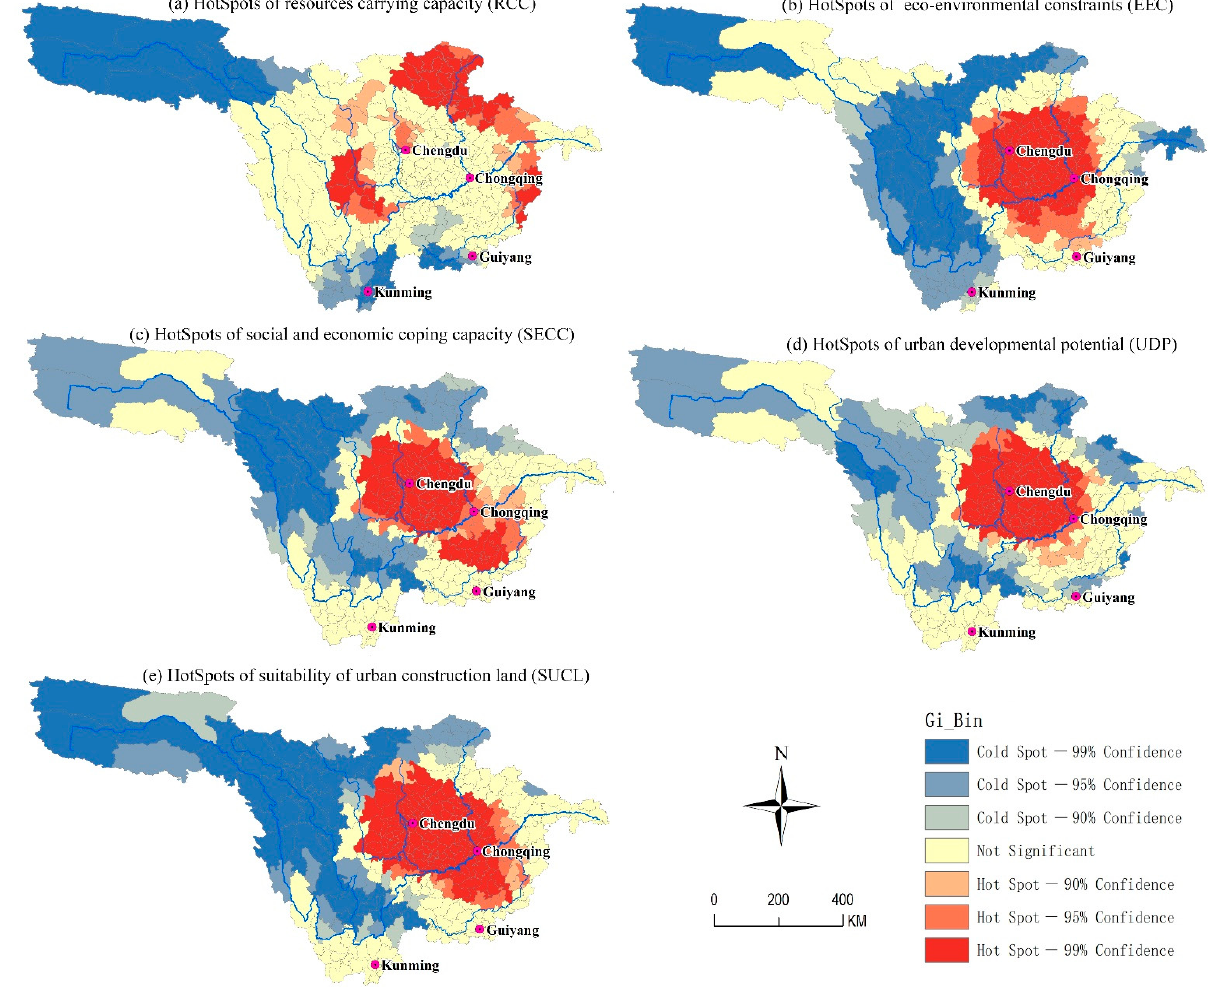
Figure 5. Spatial distribution of hot spots and cold spots of suitability of urban construction land SUCL.